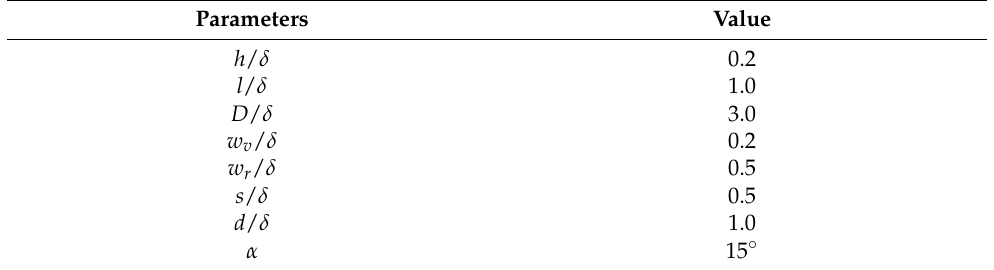
Table 1. Geometry of the MVGs.